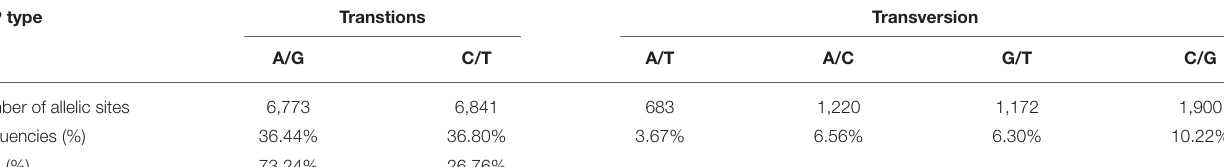
TABLE 2 | Transition (Ts) and transversion (Tv) SNPs identified using genotyping-by-sequencing.